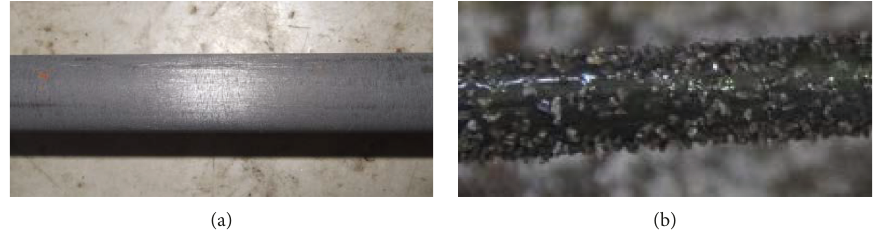
Figure 1: Surface treatment of CFRP tendon.